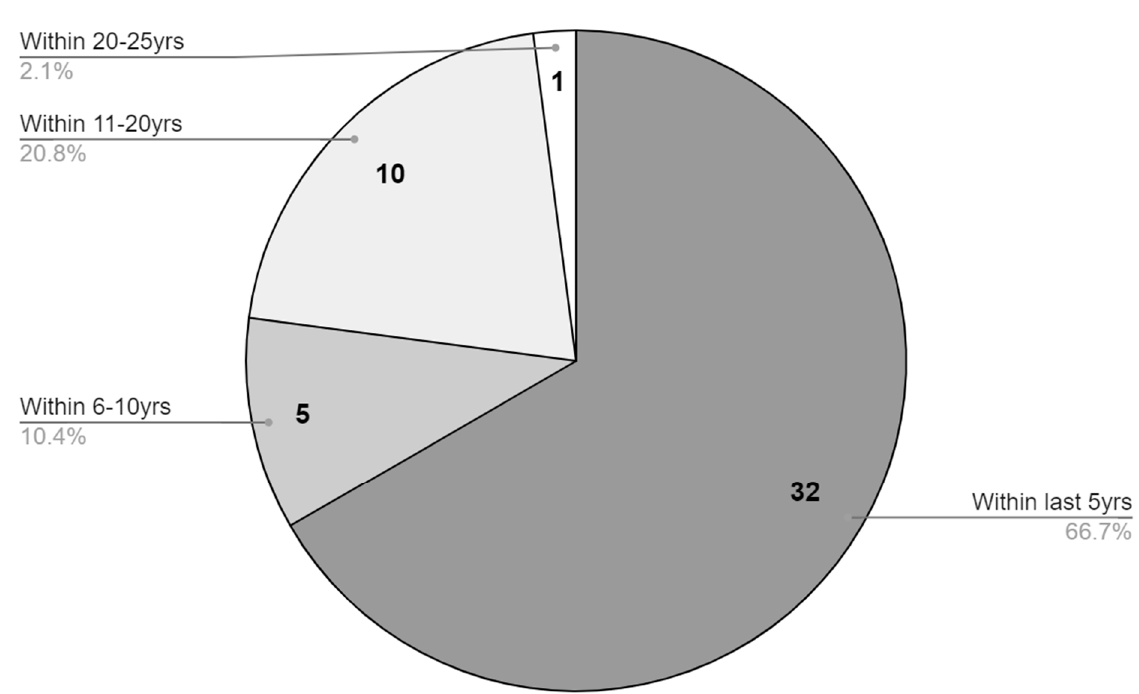
Figure 4. Distribution of studies by year.